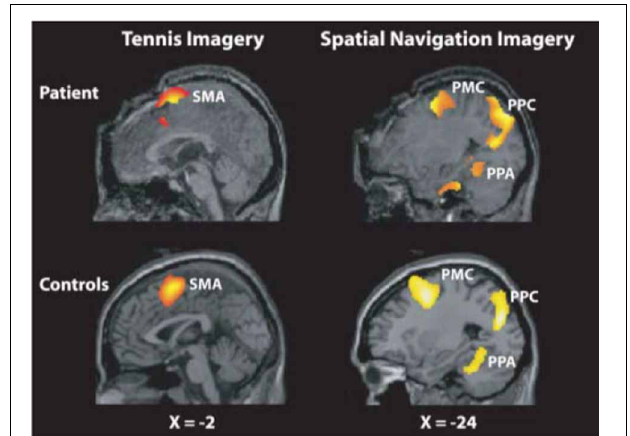
FIGURE 3 | Mental imagery paradigm used to detect covert awareness in non-communicating patients. An activation of motor cortex in response to a motor imagery task instruction (“imagine playing tennis,” on the left) or an activation of parahippocampal gyrus in response to the instruction to perform a spatial navigation mental imagery task (“imagine visiting your home,” right) can be considered as evidence of response to command, and thus of the presence of awareness, in patients unresponsive at the bedside. Reproduced with permission from (Owen et al.,